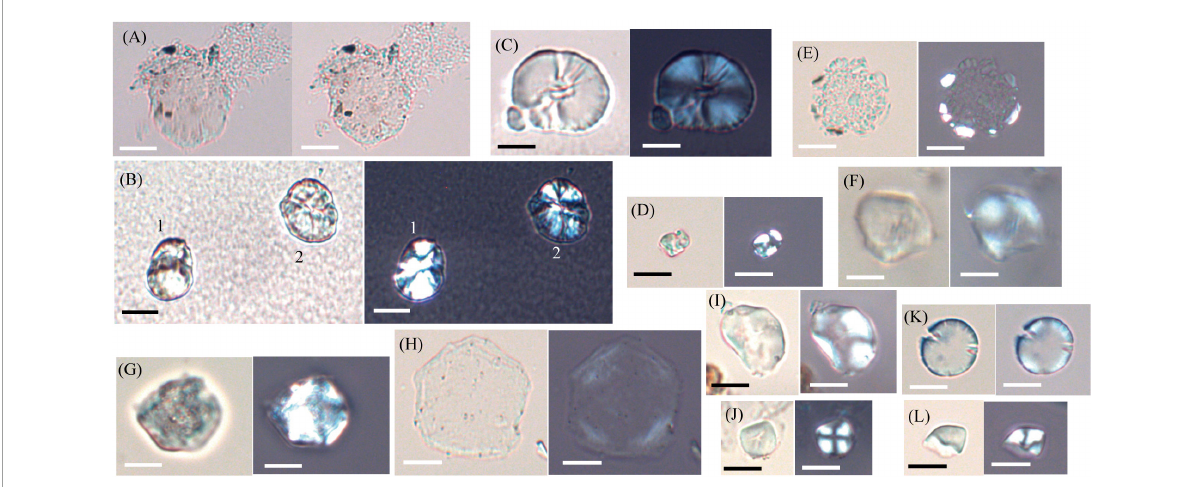
FIGURE3 Starch grains from the surveyed dental residue samples. Scale bar: 10 µ m; photographed at 400 × magnification; left: brightfield, right: brightfield with cross-polarized light. (A) Damaged starch grain of unknown species from ID 1; (B1) starch grains of unknown species from ID 3; (B2) possibly Quercus starch grain from ID 3; (C) bulb or tuber starch grain from ID 6; (D) possibly Oryza starch grain from ID 7; (E) damaged starch grain of unknown species from ID 7; (F) bulb or tuber starch grain from ID 9; (G) possibly Juglans starch grain from ID 9; (H) damaged starch grain from unknown species from ID 11; (I) possibly Castanea or Quercus starch grain from ID 11; (J) possibly Castanea or Quercus starch grain from ID 13; (K) damaged starch grain from unknown species from ID 13; (L) damaged starch grain of unknown species (Poaceae type?) from ID